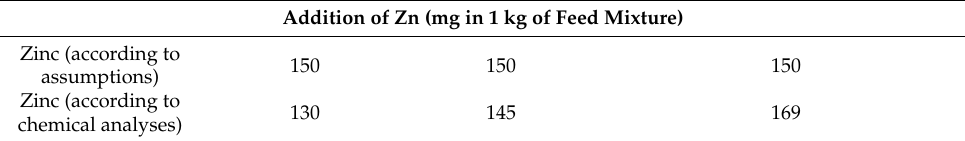
* Basic composition of all mixtures: Barley, Wheat, Maize, Soya bean meal (46% CP), Oat, Rye, Rape seed meal, H-35 Fish pulp (DM 88%), Limestone, Soy oil, Monocalcium phosphate, Premix (0.5%) **, L–lysine (98%), Sodium chloride, Bilo-Cid Bufor [acidifying mixture, composition: phosphoric acid (41%), formic acid (24%), cytric acid (11%), carrier (24%)] Kemira Pro GIT SC1, medium chain fatty acids, DL-methionine (99%), L-threonine, Choline chloride (75%), Flavor, Tryptophan, Ronozyme ® HiPhos (GT) [phytase enzyme (IUB No. 3.1.3.26): min. activity, 10,000 FYT/g] Rovabio ® Excel AP [mixture of enzymes: mainly xylanase (No EC 3.2.1.8) and β -glucanase (No